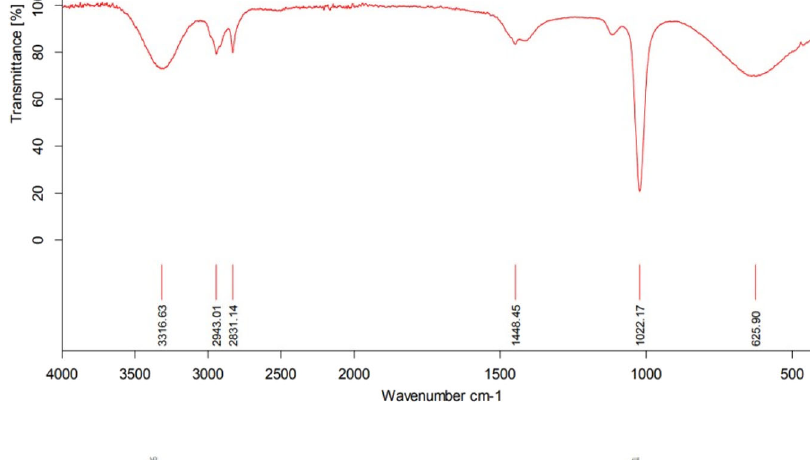
Fig. 2 13 CNMR spectra of CuO/ GO